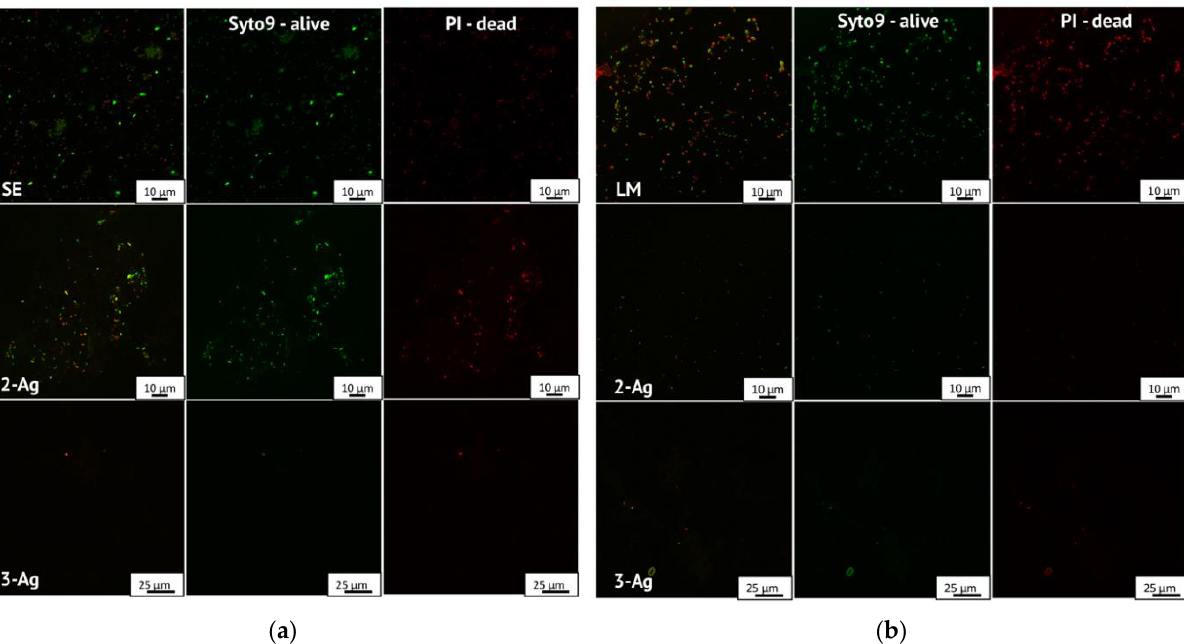
Figure 9. Visualization of biofilms tagged with fluorophores after 72 h incubation under CLSM: ( a ) Salmonella enterica SE control, treated with CS/TA/AgNPs (2-Ag) and treated with CS/GA/ TA/AgNPs (3-Ag); ( b ) Listeria monocytogenes LM control, treated with 2-Ag and treated with 3-Ag. Represented in green—tagged with SYTO9—are alive bacteria, in red—tagged with Propidium Iodide (PI)—are dead bacteria, and merged images of green and red signals are also